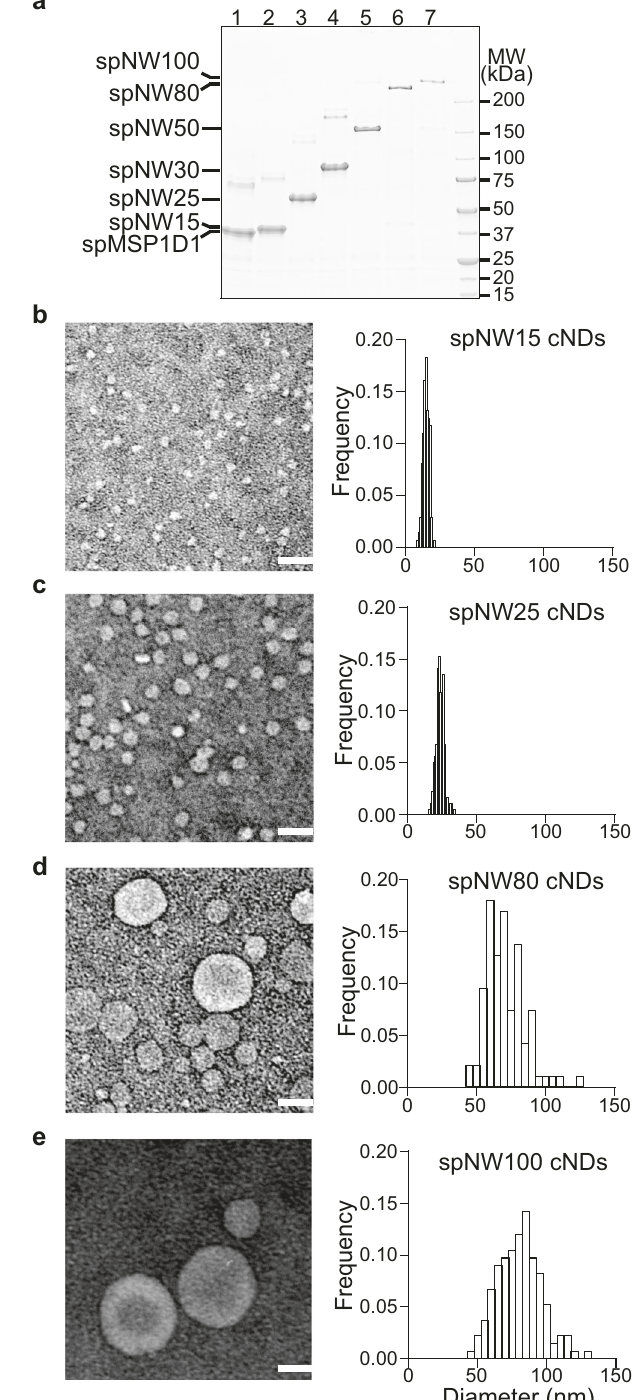
Fig. 4 Extending the size range of cNDs. a Representative SDS-PAGE of spNW15 (lane 2), spNW25 (lane 3), spNW80 (lane 6), and spNW100 (lane 7) in comparison with spMSP1D1 (lane 1), spNW30 (lane 4), and spNW50 (lane 5). n = 3 independent experiments. b – e , EM micrographs (left) and size distribution (right) of cNDs made using spNW15 ( b ), spNW25 ( c ), spNW80 ( e ) and spNW100 ( e ). n = 136 (spNW15), 177 (spNW25), 94 (spNW80), and 133 (spNW100). scale bar, 50nm. Source Data are available as a source data fi